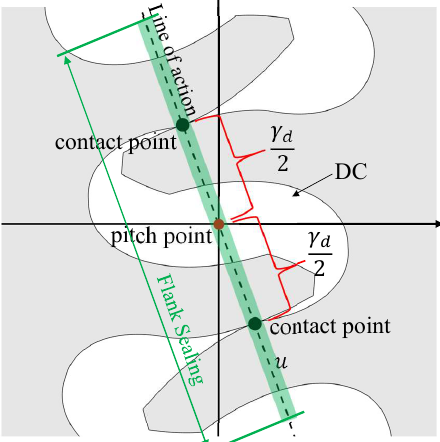
Figure 13. Zero angle ( φ = 0) position for a DC of an EGP, where two delimiting contact points have equal distance to the pitch point. The tooth-flank sealing region on the primary line of action is shaded by